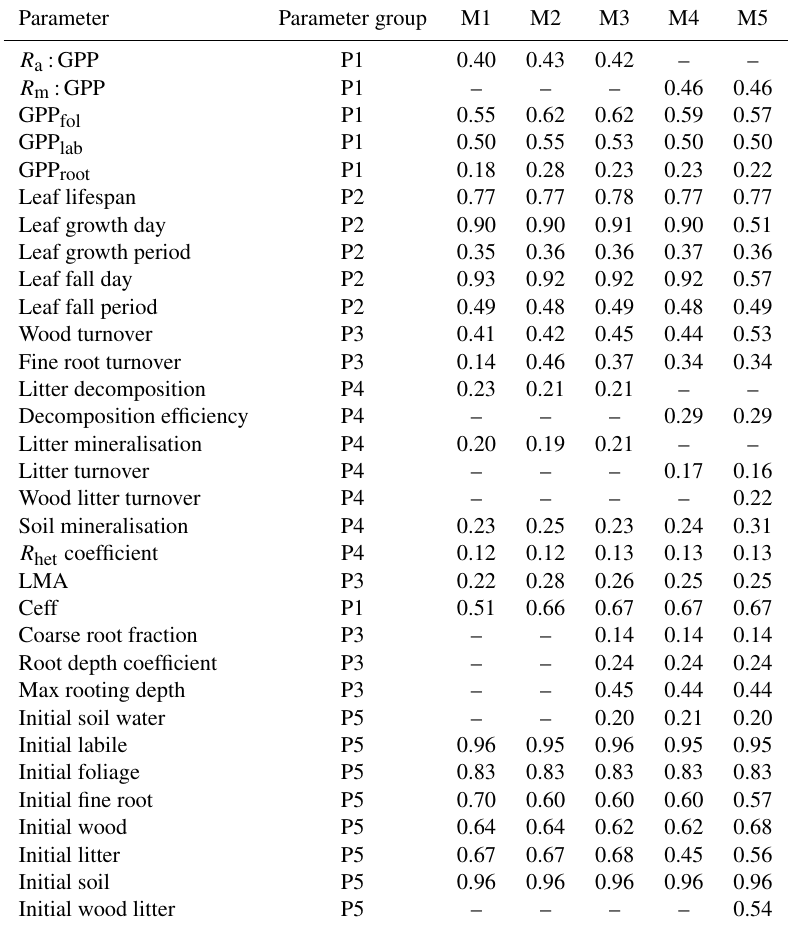
Table A2. Summary information of posterior parameter constraint for each model. Presented is the Brazil-wide mean of 1 − posterior : prior, indicating the relative reduction in parameter uncertainty for each DALEC model. As not all parameters are used by all models, the row value will be left black where a parameter is not applicable. Each parameter is also allocated to one of the following broad parameter definitions: GPP allocation (P1), canopy phenology (P2), other plant turnover (P3), decomposition processes (P4) and initial conditions (P5), which are used to provide parameter group means in Table A3. Note: gross primary productivity is indicated as GPP, autotrophic respiration is indicated as R a , autotrophic maintenance respiration is indicated as R m , and heterotrophic respiration is indicated as R h . Litter is assumed to be the combined foliage and fine root litter pools, where appropriate wood litter will be explicitly stated. Note that GPP allocation fractions